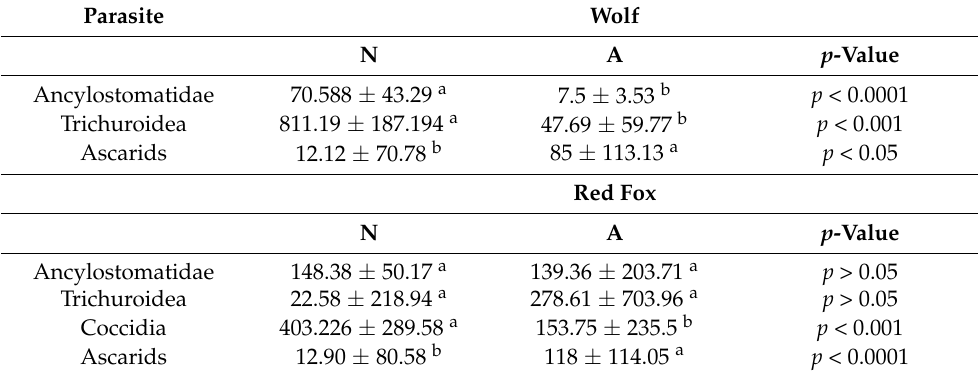
Table 4. Number of coccidian oocysts/gram of feces (OPG) and nematode eggs/gram of feces (EPG) counted in wolf and fox fecal samples collected in the anthropized (A) and natural (N) areas, respectively. Values are expressed as average ± SE (median). Significant differences are indicated with different superscript